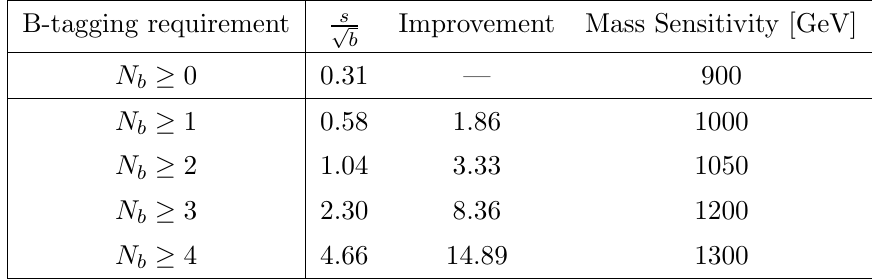
p Table 1. The approximate improvement in s= b and mass reach as a function of increasing number of b -tags, N b . The (cid:12)rst line is the actual limit, while the subsequent lines are estimated potential p improvements. The s= b values are computed at the cut o(cid:11) region of m T = 900 GeV for the three-jet CMS search [49] with 35.9 fb (cid:0) 1